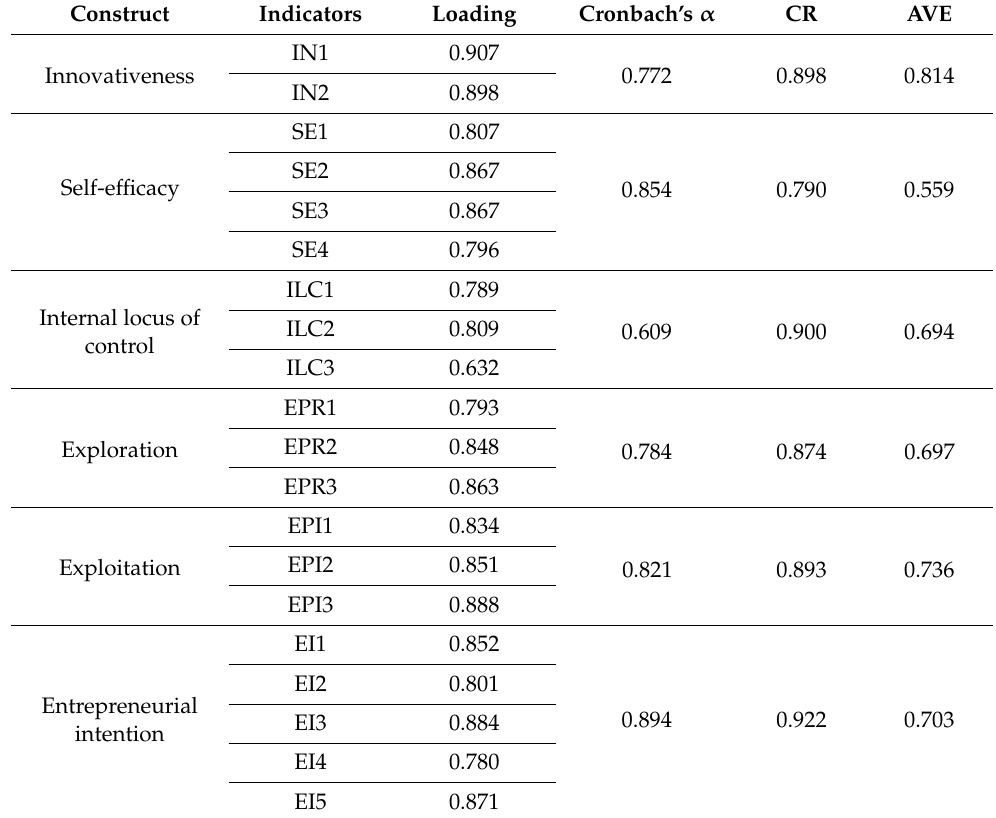
Table 5. Reliability and validity estimation.